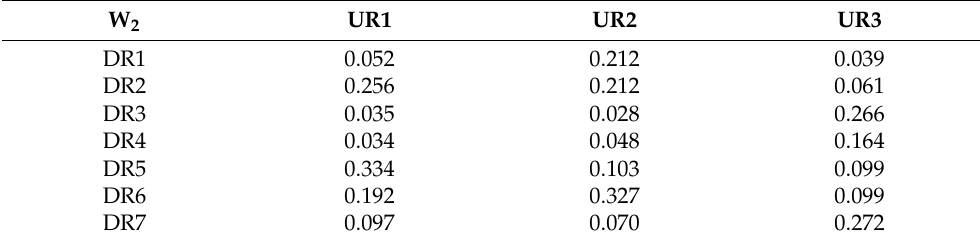
Table 9. Relative weights of DRs with respect to each UR (W 2